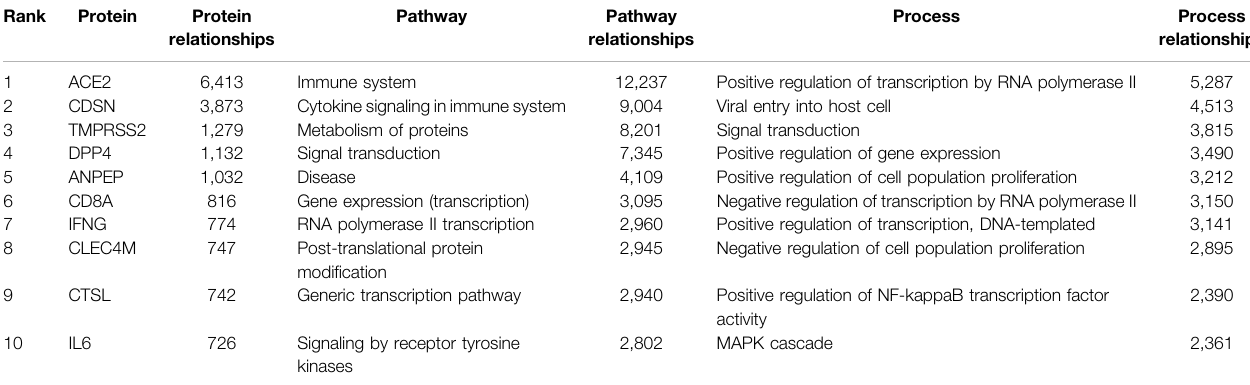
TABLE 1 | Top 10 host proteins, pathways and GO processes associated with SARS-CoV-2 infection.